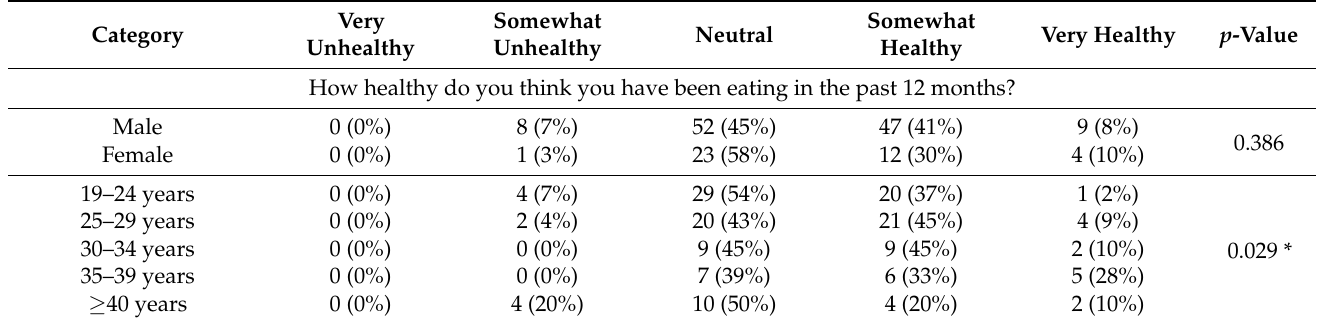
Table 2. The association between sex, age, and type of occupation and participants’ response to “How healthy do you think you have been eating in the past 12